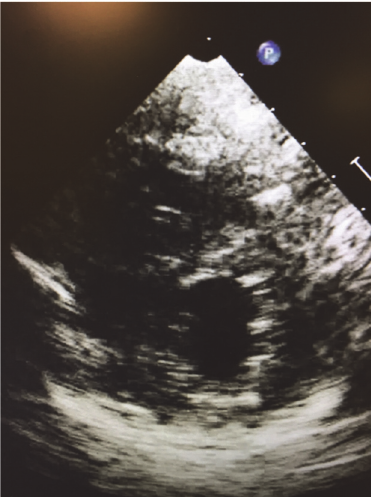
Figure 7: Echocardiogram parasternal short axis showing left ventricular chamber back to normal size and